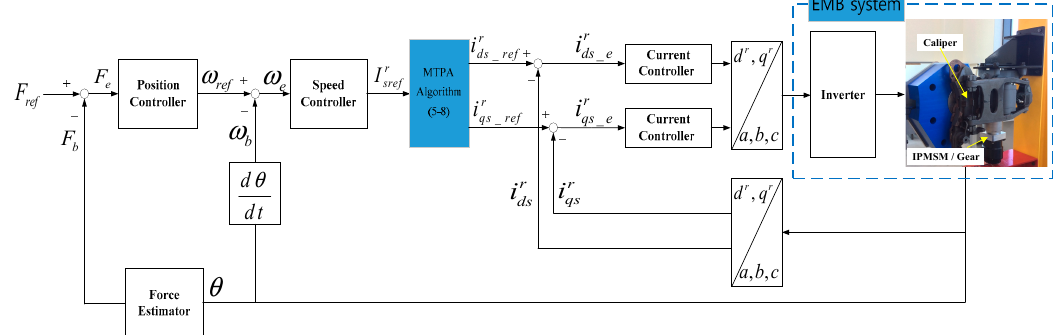
Figure 5. IPMSM control concept of EMB system.